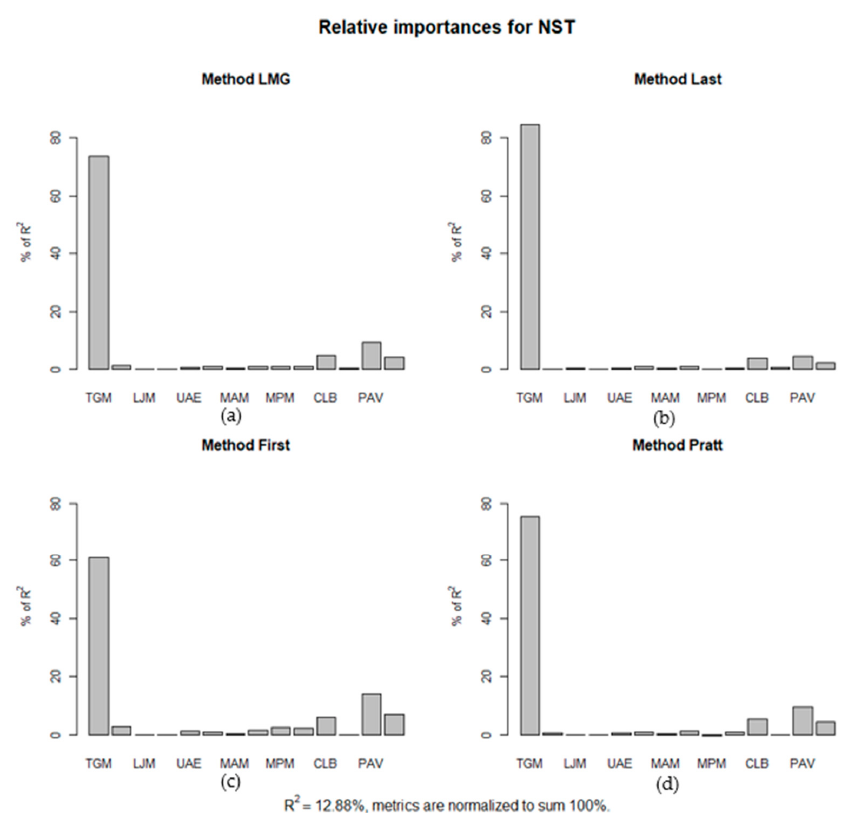
Figure 1. Relative importance of the research predictors: ( a ) The variance decomposition metric. Method LMG (Lindeman, Merenda, and Gold); ( b ) method last; ( c ) method first; and ( d ) Pratt method.